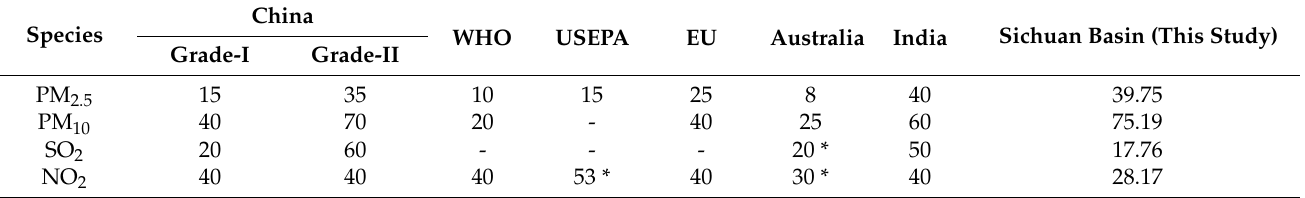
Table 2. Comparison of the annual average concentration of the four pollutants with the available standards. China Species WHO USEPA EU Australia India Sichuan Basin (This Study) Grade-I Grade-II PM 2.5 15 35 10 39.75 PM 10 40 70 SO 2 20 60 - - - 50 17.76 NO 2 40 40 40 53 *